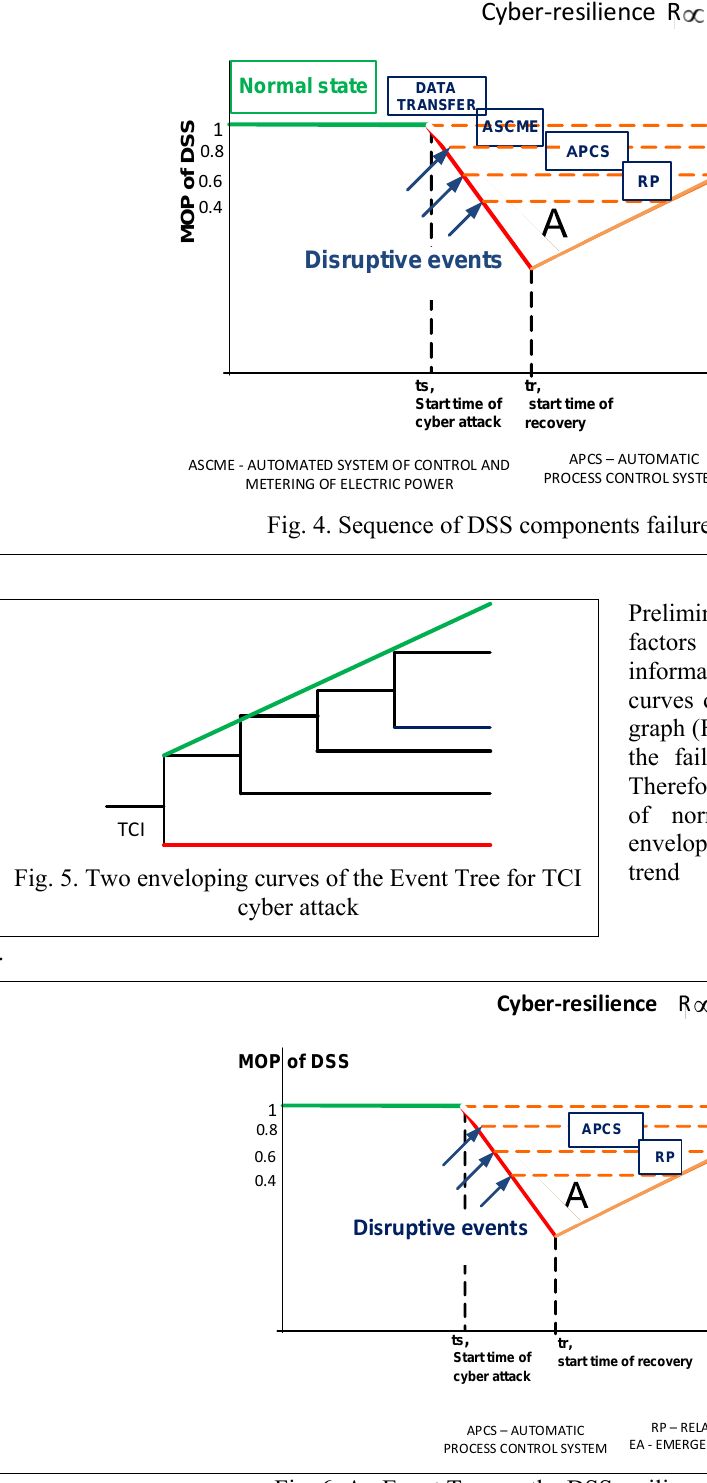
Fig. 6. An Event Tree on the DSS resilience graph for TCI